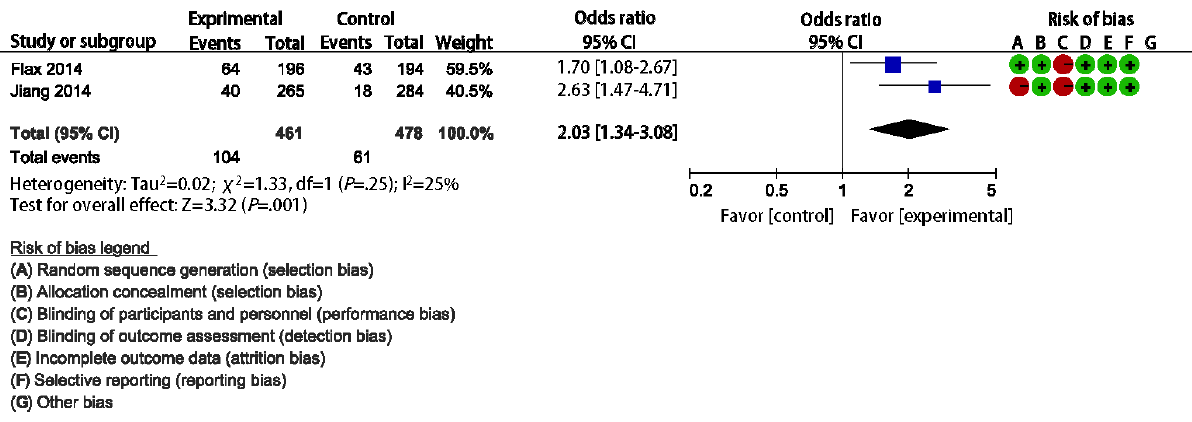
Figure 3. Meta-analysis of the effect of mHealth intervention versus routine prenatal care on exclusive breastfeeding for 6 months based on two studies undertaken in Nigeria and